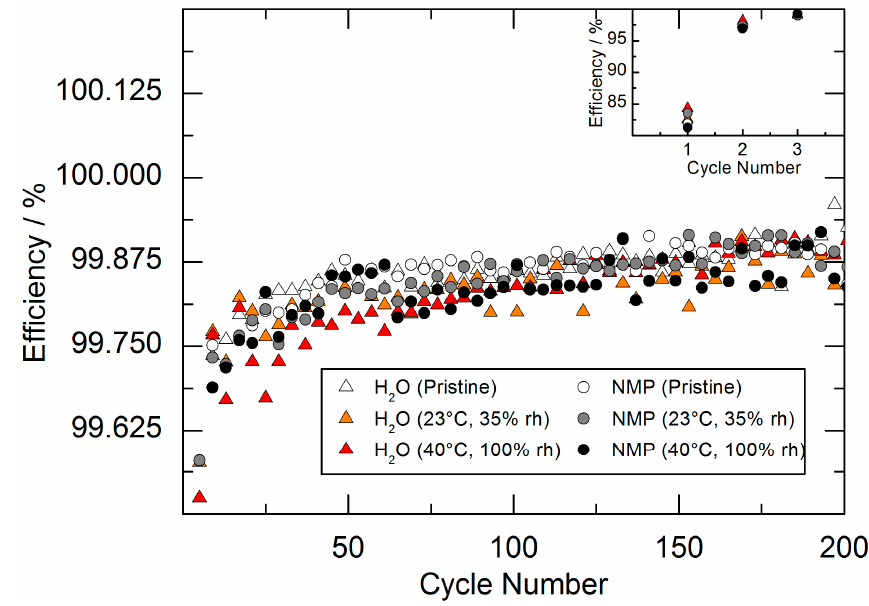
Figure 6. Comparison of long-term discharge capacity fading of full-cells assembled with anodes containing different types of graphite. MAG-D is a synthetic and SGB 10 MOZ V12 is natural graphite. For better comparability, the measured initial discharge capacities are set to 100%.